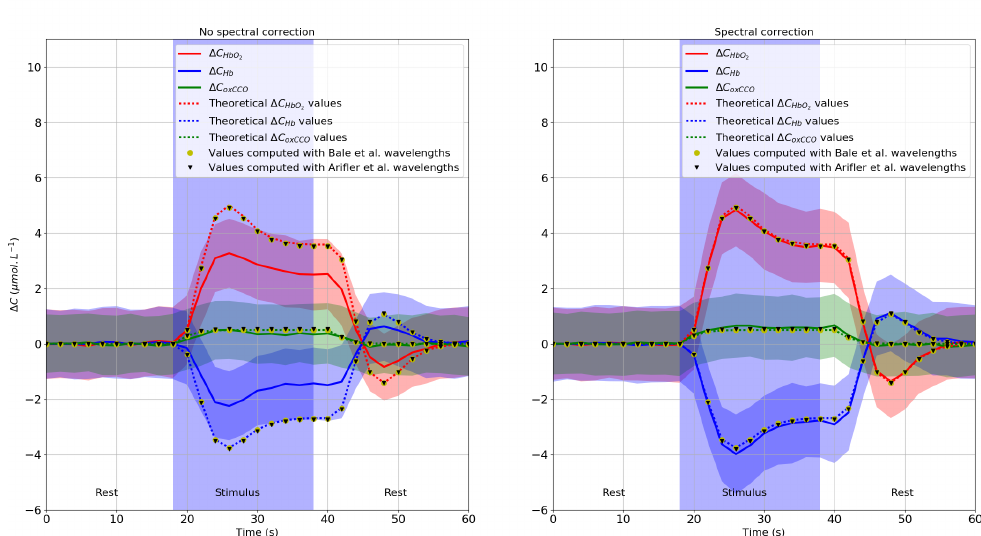
Figure 12. Hemodynamic and metabolic monitoring following neuronal activation computed with the optimal spectral configuration obtained with the simulation-based method (see Figure 7). The dashed lines represent the theoretical hemodynamic and metabolic responses following the neuronal stimulation. The dispersion ranges of the measurements are represented by colored areas. The concentration changes averaged over the 10 3 noisy measurements are represented in solid lines. The concentration changes’ time courses computed with the 121 wavelengths included between 780 nm and 900 nm [23] are represented with yellow points. The ones computed with Arifler et al.’s wavelengths [27] are represented with black triangles. The blue rectangle represents the “patient” physiological